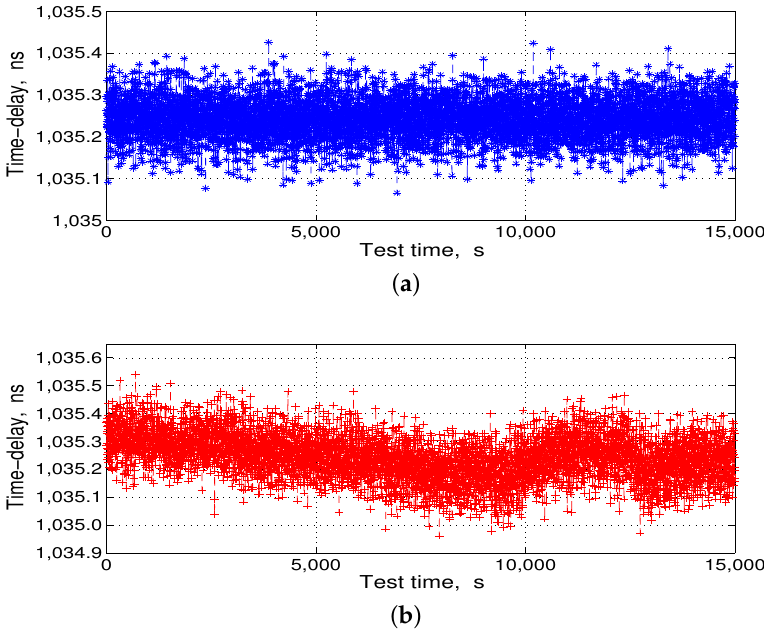
Figure 12. Reception-delay compensation comparison test results. ( a ) test at 14 ◦ C; and ( b ) test at − 30–60 ◦